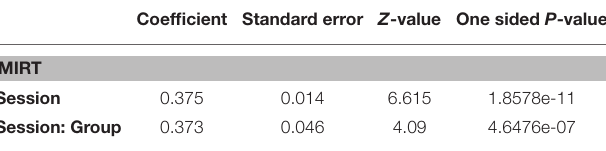
TABLE 5 | ANOVA table for fixed effects of Session and Session:Group